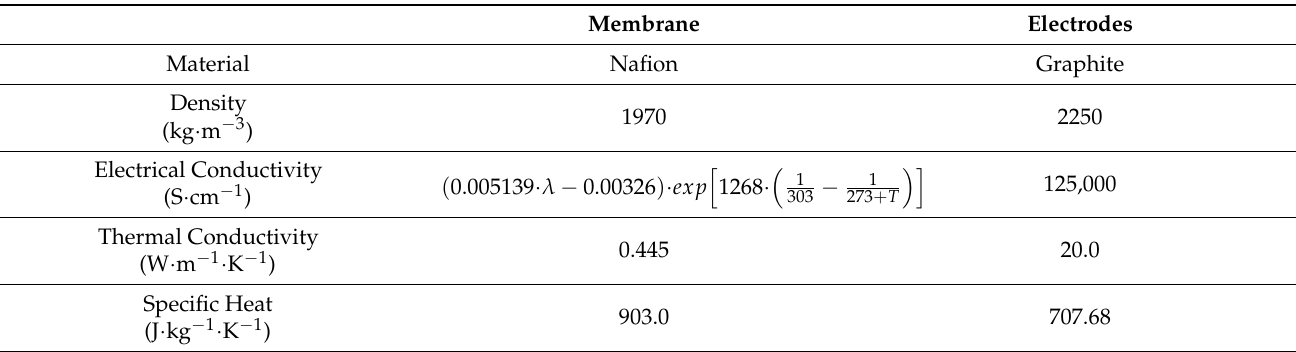
Table 1. Solid material